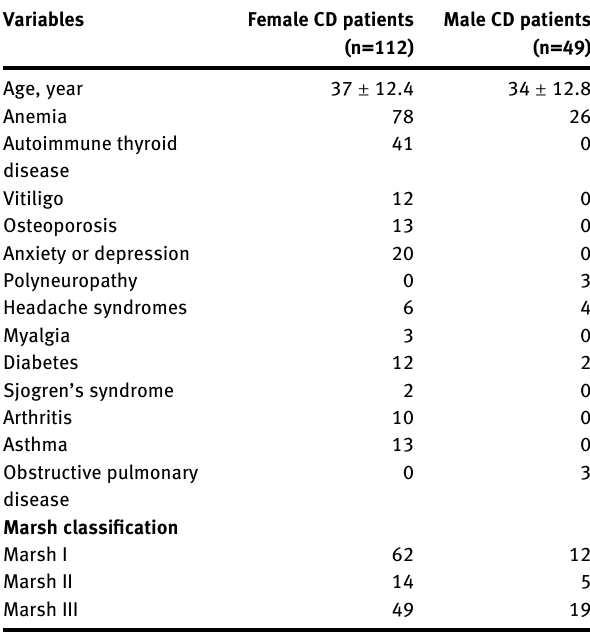
Table  : Clinical and demographic features and intestinal mucosal damage degrees of CD